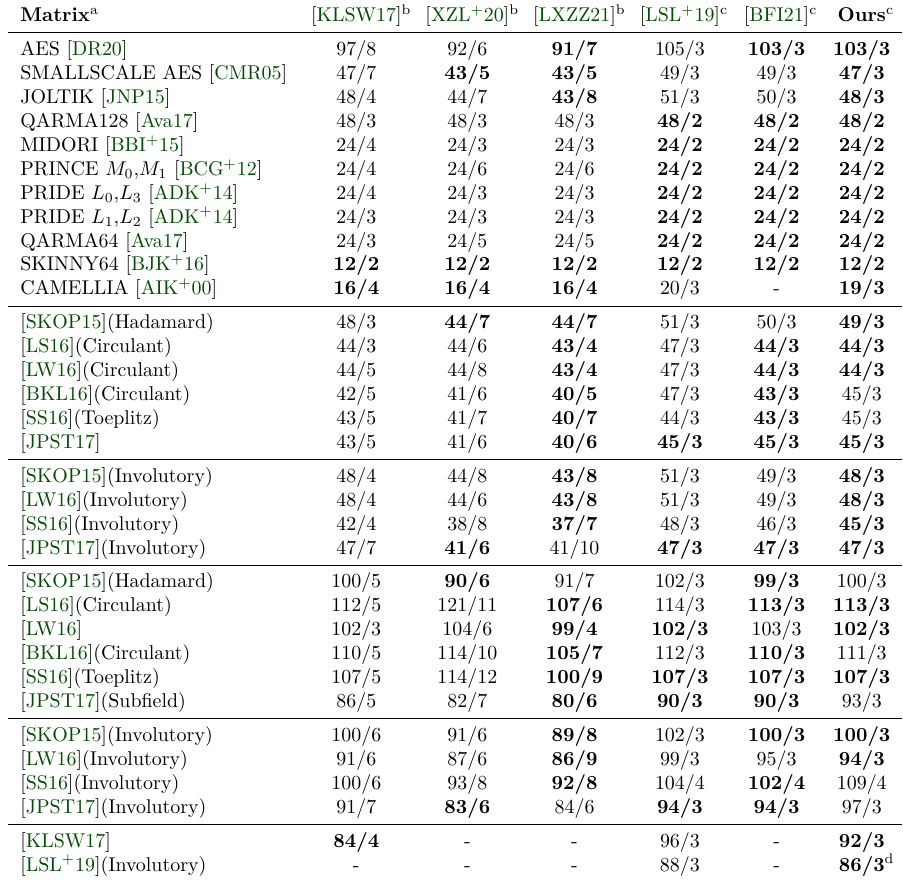
Table 2: The XOR number/depth of implementation cost of matrices. Except for the last row, every matrix is consistent with the choice in [KLSW17].